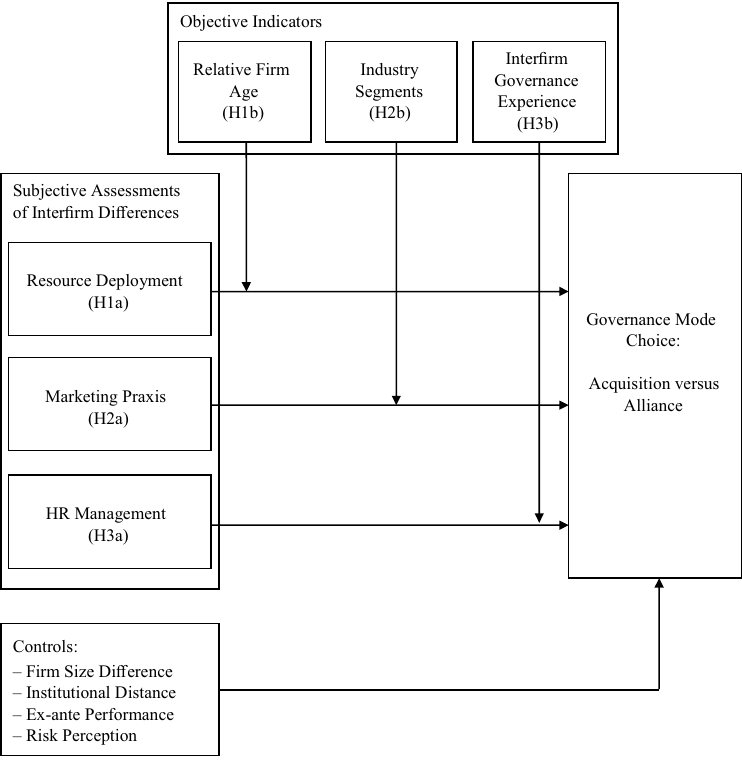
Fig. 1. The conceptual